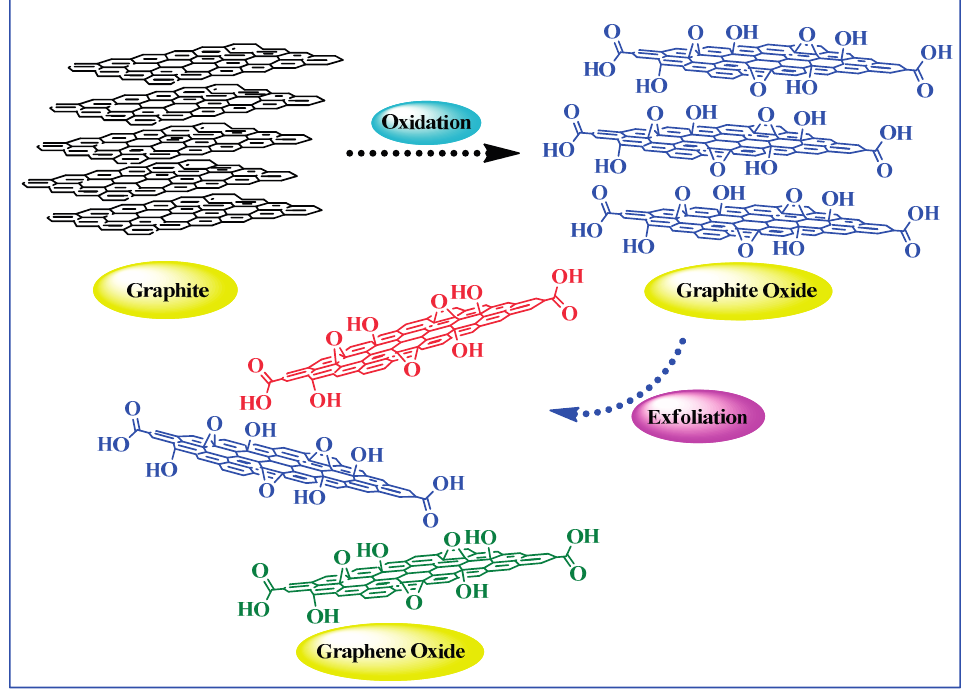
Figure 2. Synthesis of graphite oxide and graphene oxide (GO) from natural